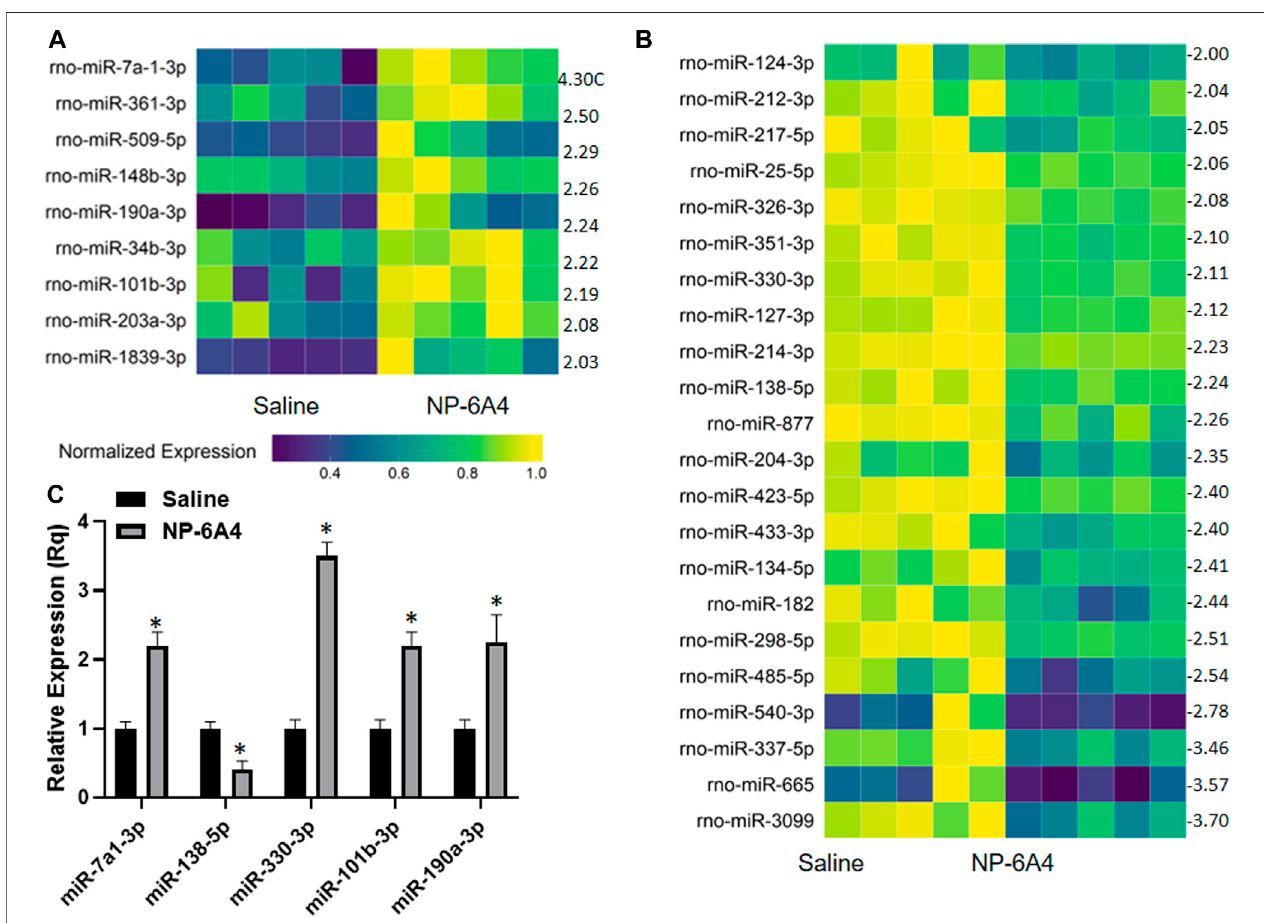
FIGURE6| NP-6A4modulatesacardiacmicroRNAsthatcanpotentiallyregulatetheanti-in fl ammatoryproteinnetworkinZOratheart. (A and B) Heatmapsshow graphic representation of relative expression of intracardiac microRNAs that exhibited at least a two-fold increase (A) or two-fold decrease (B) in NP-6A4-vs. saline- treated ZO rat hearts. n (cid:1) 5 animals per group. Yellow indicates the highest expression for each cytokine (1.0), while dark blue indicates lower expression relative to the sample with the highest expression. Expression was normalized for each microRNA across all animals (across each row). Statistical signi fi cance was determined using Student ’ s t -test. p < 0.05 for all differentially expressed miRNAs. Supplementary Tables S4A,B list all miRNAs that exhibited at least 1.5-fold differential expression. (C) Graph shows the results of quantitative RT-PCR analysis of some of the differentially expressed miRNAs in NP-6A4 vs. saline treated ZO rat hearts previously identi fi ed by microarray analysis. n (cid:1) 6 animals per group and qRT-PCR was performed in triplicates. * p < 0.05 for saline-treated vs. NP-6A4 treated as determined by two-tailed paired t